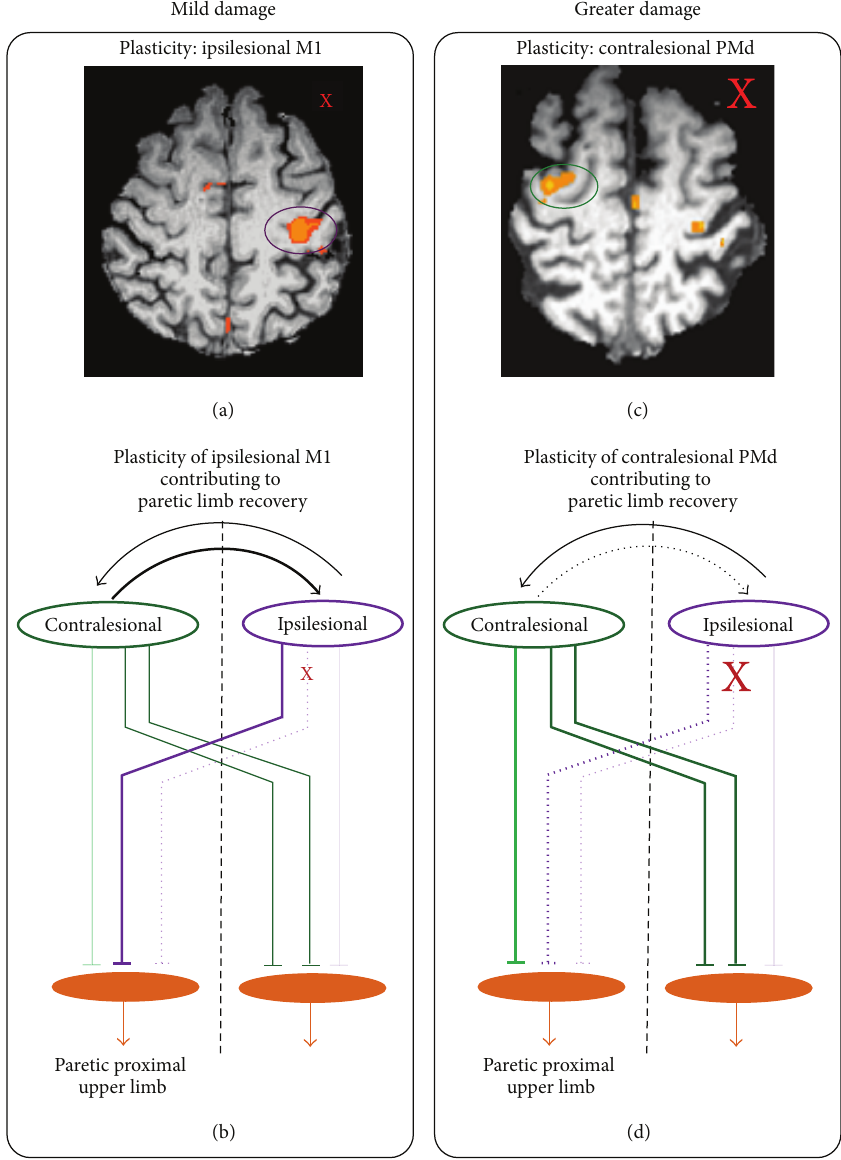
Figure 2: How contralesional PMD contributes to recovery of the paretic upper limb. Plasticity of ipsilesional M1 (iM1) is best evident in patients who are mildly impaired and have little damage to iM1 and corticospinal pathways because (a) they can feasibly recruit ipsilesional M1 in movement of the paretic upper limb in functional MRI (fMRI) and (b) can increase output of spared ipsilesional pathways (bold purple lines) to support the paretic limb. (c) Since, with greater damage, plasticity of ipsilesional M1 or any ipsilesional substrates is less likely, these patients recruit contralesional PMd in movement of the paretic limb. (d) Contralesional PMd reduces its inhibition on weak ipsilesional M1 (dotted black lines) so it partially supports paretic limb recovery (bolder, dotted purple lines). Also, contralesional PMd offers ipsilateral pathways (green) (uncrossed corticospinal and brainstem-mediated reticulospinal) to the proximal paretic limb to help recover [38, 80].